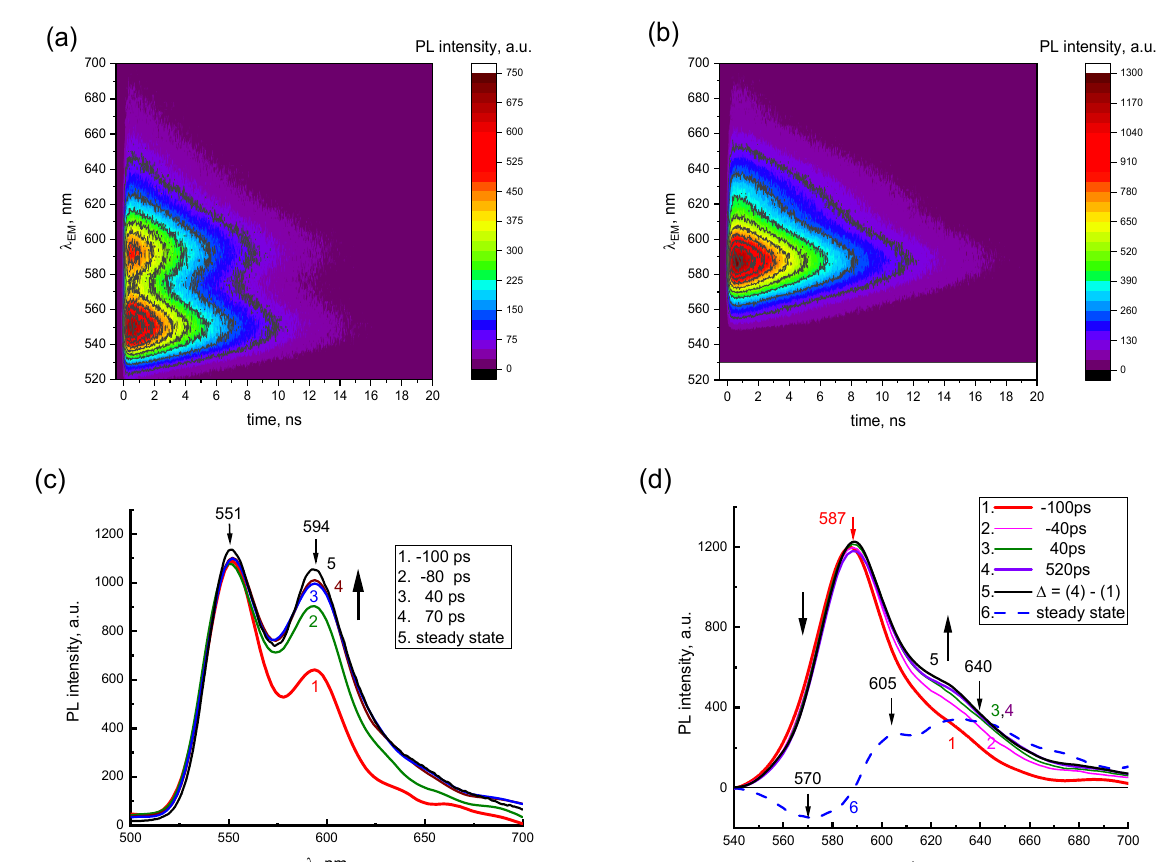
Figure 5. TRES maps ( a , b ) and instantaneous PL spectra at various delay times ( c , d ) of aqueous solutions of 2416SL for two concentrations 10 − 4 M ( a , c ) and 10 − 3 M ( b , d ). The following delay times are presented: ( c ) − 100 (1), − 80 (2), 40 (3), 70 ps (4); ( d ) − 100 (1), − 40 (2), 40 (3), 520 ps (4). The steady-state spectra (5) are shown as a reference. ( d ) Differential spectrum, ∆ , (6) is obtained by subtraction of spectrum (1) from spectrum (4). λ e = 405 nm; T = 296